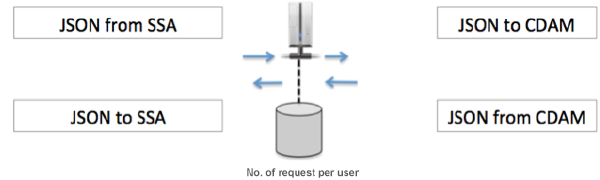
Figure 3. SSA component responsible for data persistence and for the exchange of information between the UI and the message bro-